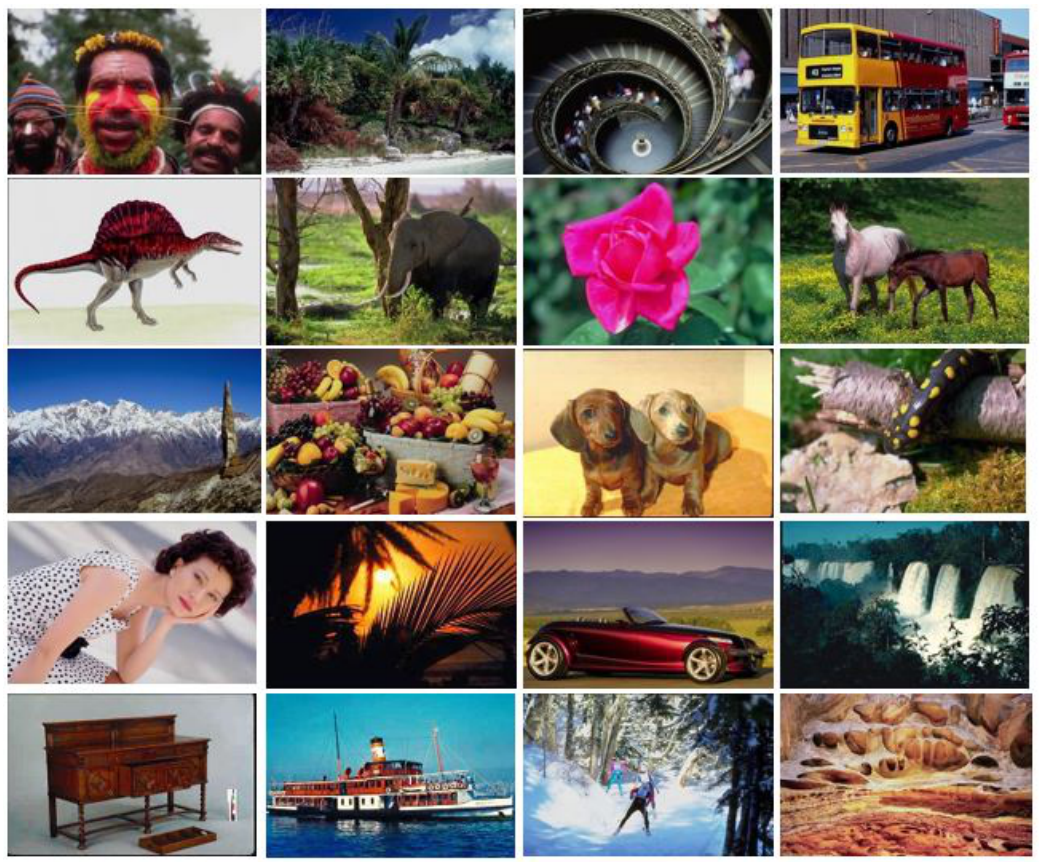
Figure 6. Class representatives from the Corel 2000 image dataset [40].